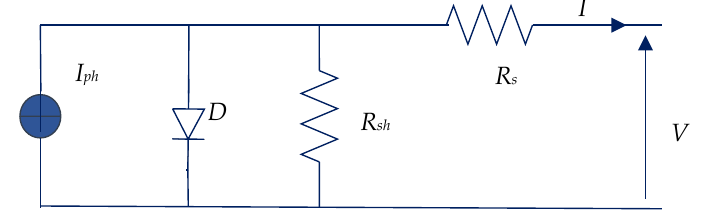
Figure 2 . Electrical model of a photovoltaic cell [24].